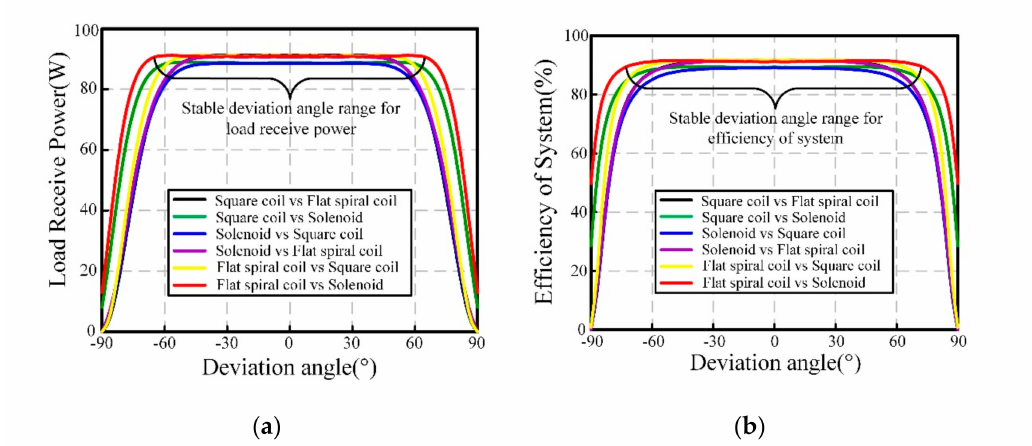
Figure 12. Simulation results under di ff erent coil types. ( a ) Load receive power vs. deviation angle. ( b ) E ffi ciency of system vs. deviation angle.